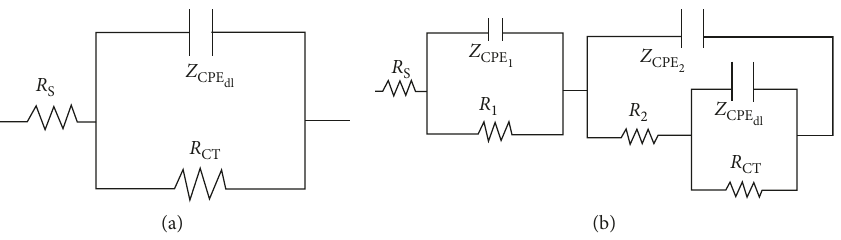
Figure 16: Equivalent circuits: (a) without addition of inhibitor: (b) with addition of inhibitor synthesized from permanent magnets. Table 2: Evolution of the electrochemical parameters of the EIS spectra of API X70 steel in the absence of inhibitor. Time